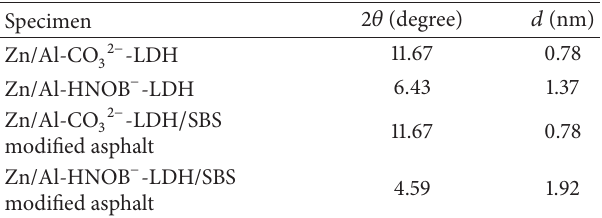
Table 1: X-ray diffraction angles of Zn/Al-CO 32− -LDH, Zn/Al- HNOB − -LDH, Zn/Al-CO 32− -LDH / SBS modified asphalt, and Zn/Al-HNOB − -LDH/SBS modified